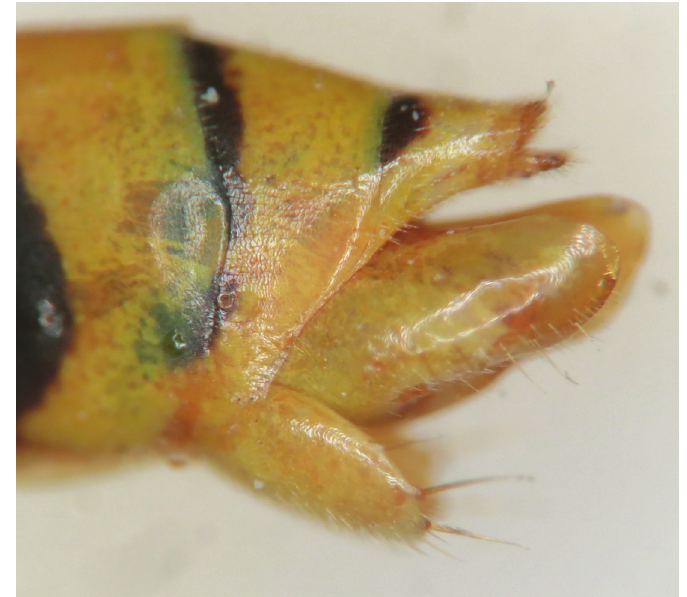
Figure 11. Hellwigia elegans , apex of male metasoma (Turkey).